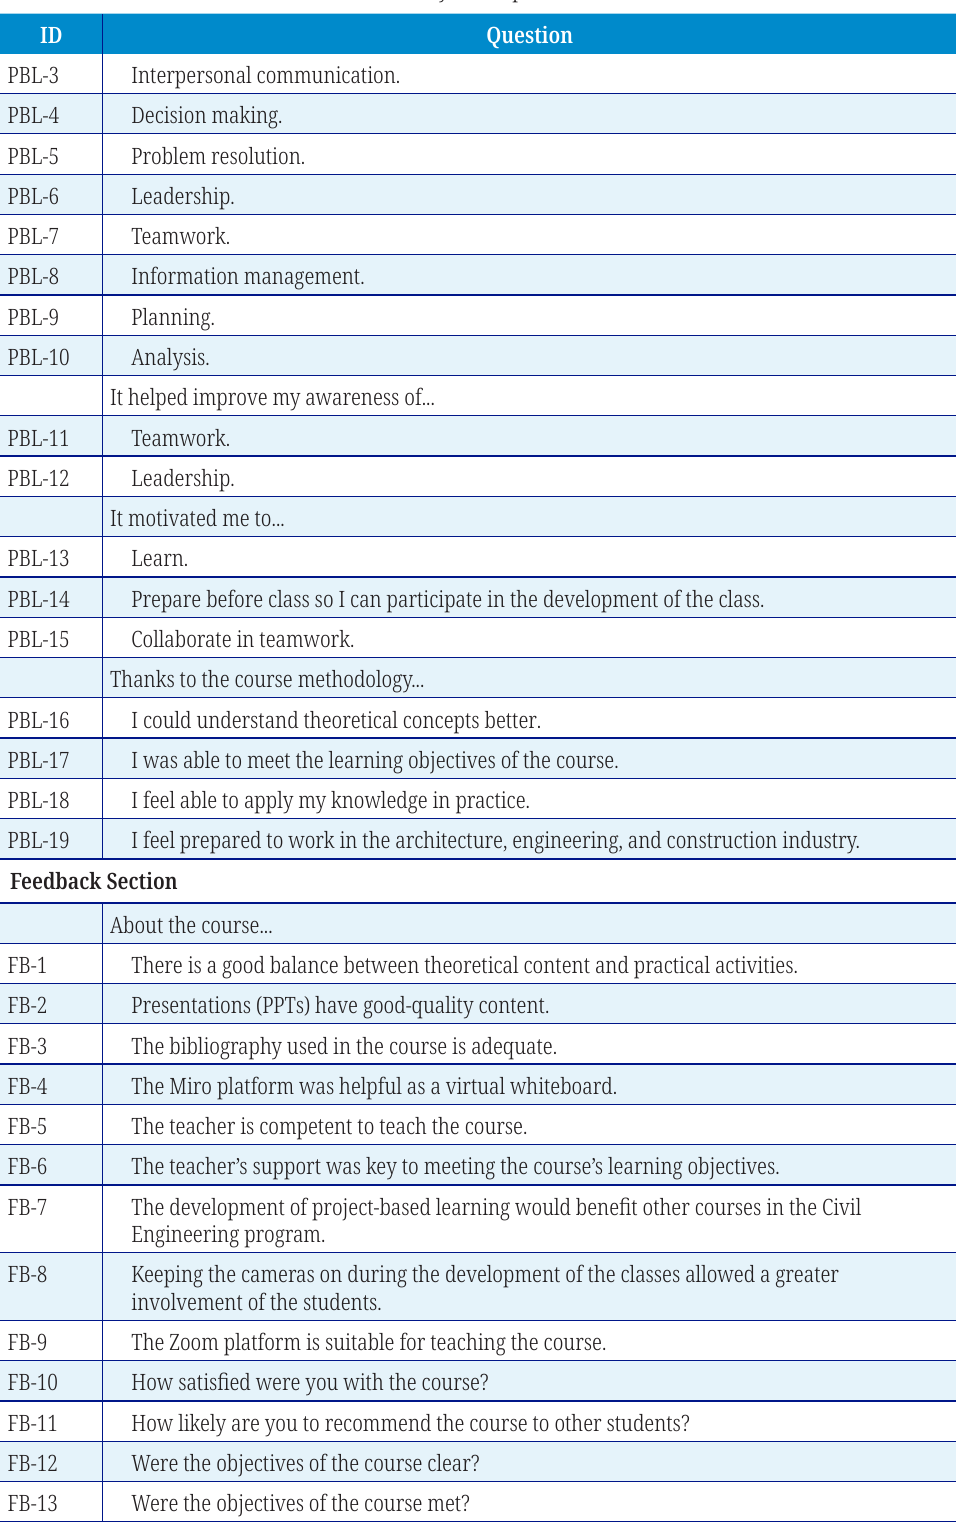
Table 6. Survey developed